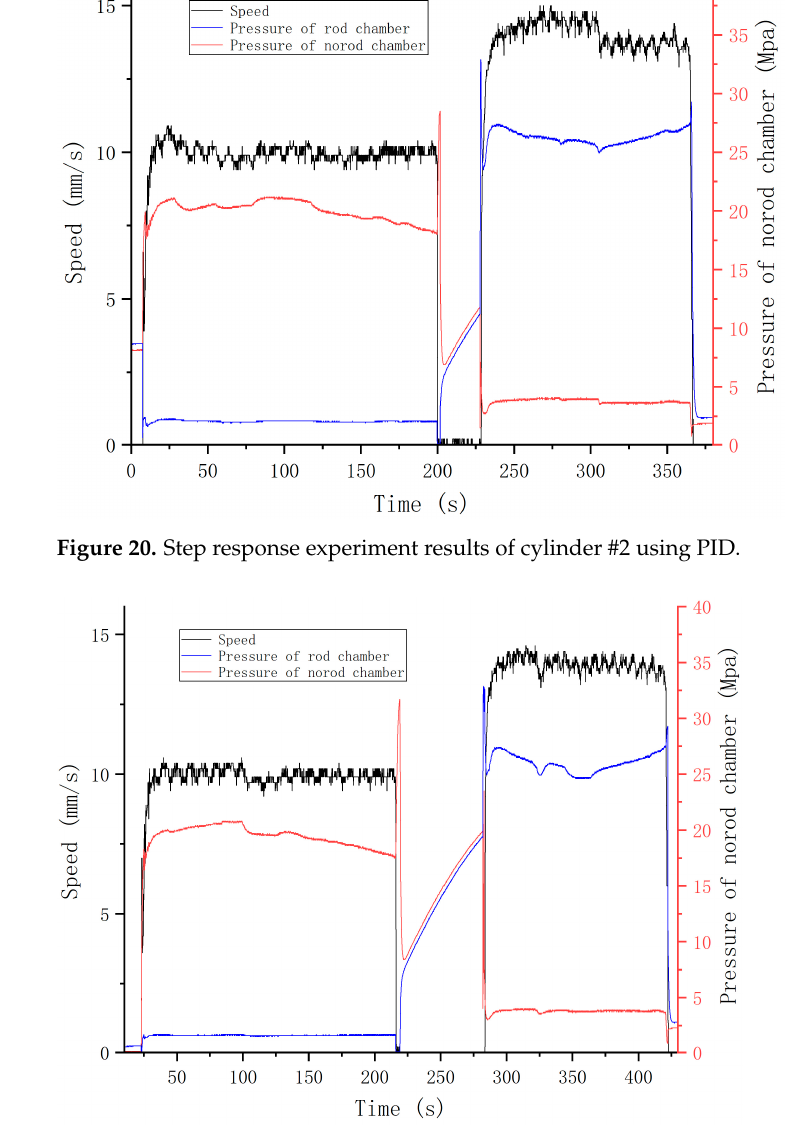
Figure 21. Step response experiment results of cylinder #2 using FLADRC.